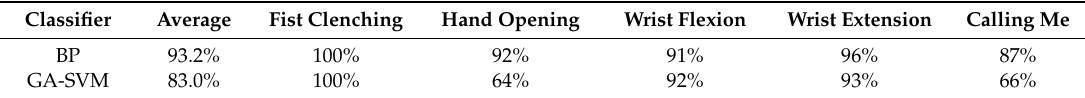
Table 2. Three-feature-combination joint action classification of BP neural network and GA–SVM. This table explores the performance of the BP neural network and the GA–SVM, based on the same features (MAV, WL, and RMS). Each row represents the accuracy of di ff erent actions based on a certain classifier. Each column represents the accuracy of a single action, based on di ff erent classifiers. We also calculated the average accuracy for better comprehensive comparison.